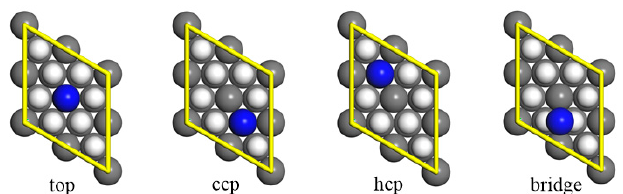
Figure 4. Atomic nitrogen adsorption onto PuH 2 (111) surfaces with different sites: top, ccp, hcp, and bridge site. The gray, blue, and white spheres represent Pu, N, and H atoms, respectively. Table 2. Adsorption energies of atomic nitrogen adsorption onto PuH 2 (111) surface. Adsorption parameter r d is the vertical distance from the surface and and r Pu-N is the average distance of Pu-N.